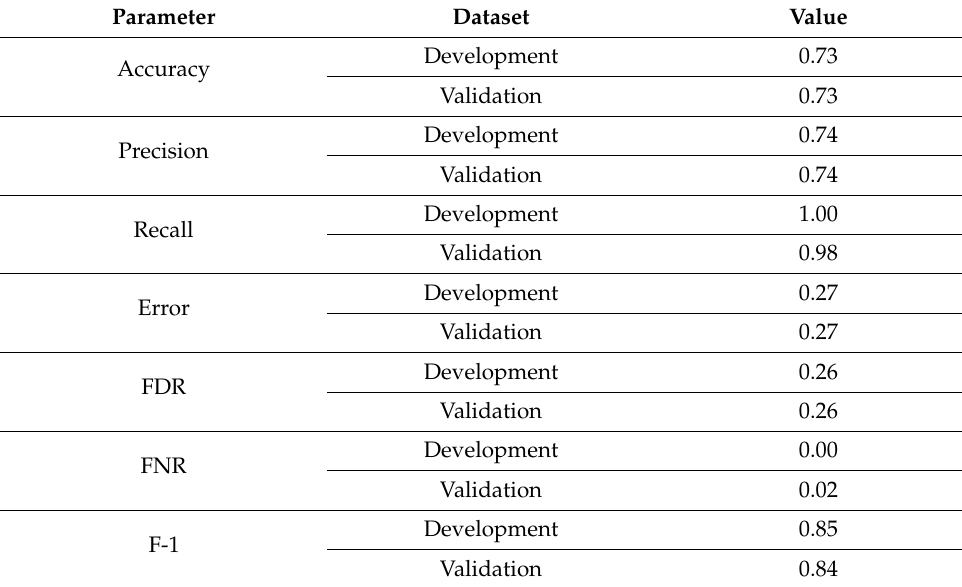
Table 7. Accuracy measures for the logistic regression